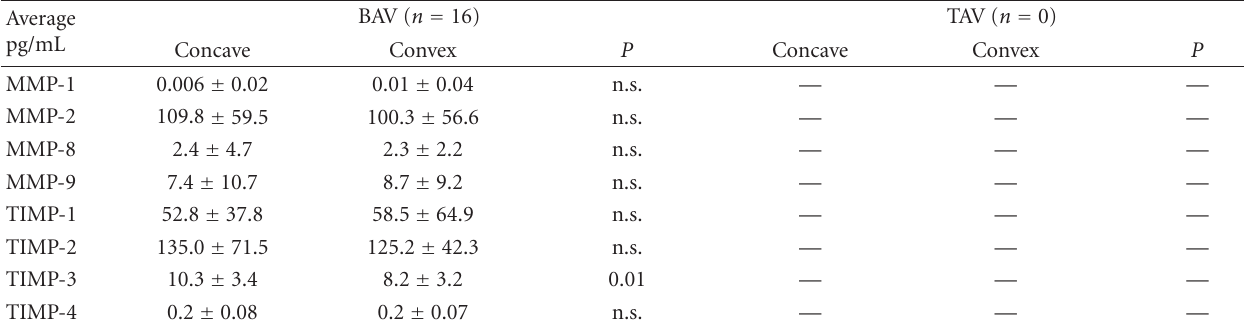
Table 3: Age di ff erences and detection of MMPs and TIMPs in BAV and TAV patients aged ≤ 51 years. Average